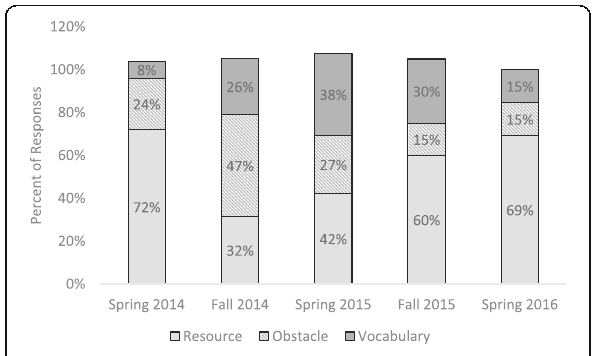
Fig. 7 Averaged week 15 coding percentages. Percentage of week 15 student responses coded as student ideas in conjunction with constructing knowledge and formative assessment . Note that the columns are mutually